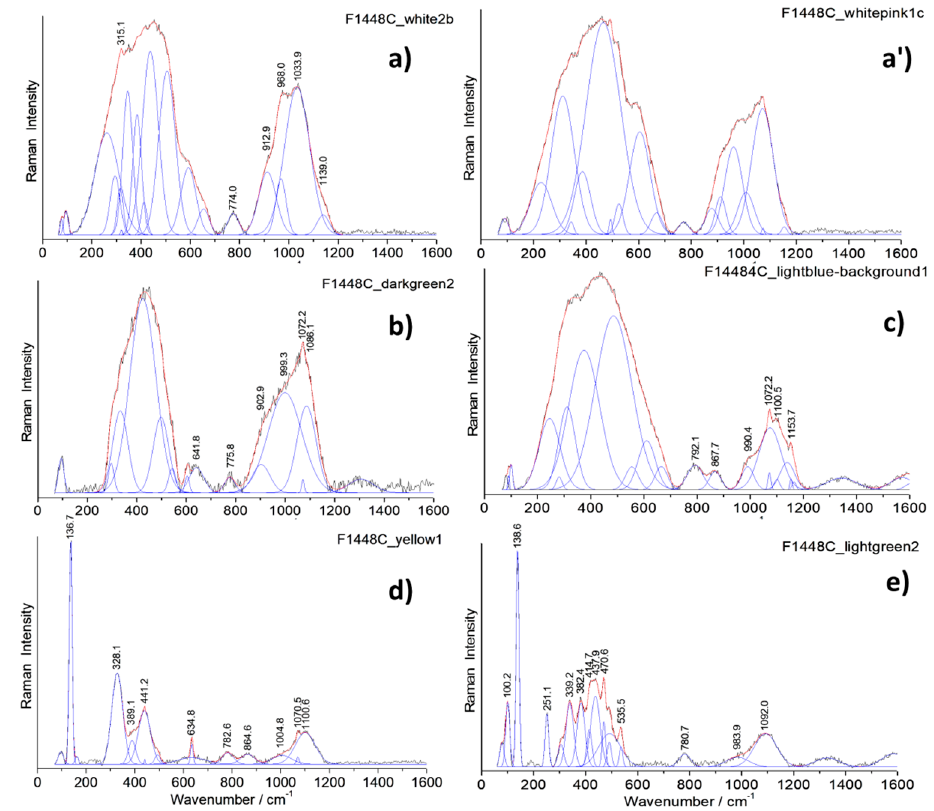
Figure 8. Representative Raman spectra recorded on the cloisonné enamels of the incense burner (baseline subtracted): white ( a ), white-pink ( a ′ ), dark green ( b ), turquoise ( c ), yellow ( d ) and light green ( e ) areas. Gaussian and Lorentzian components used to separate the contribution of the crystalline pigment from that of the glassy matrix are shown.